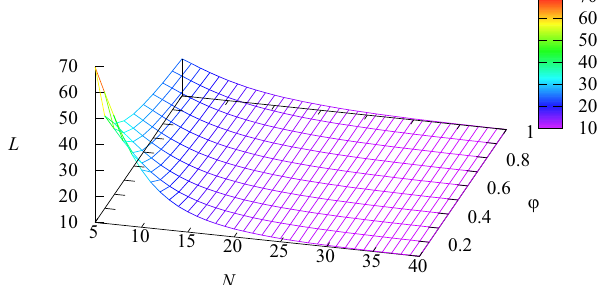
Figure 2. Dependence of the mean number of requests in the system L on ϕ and N